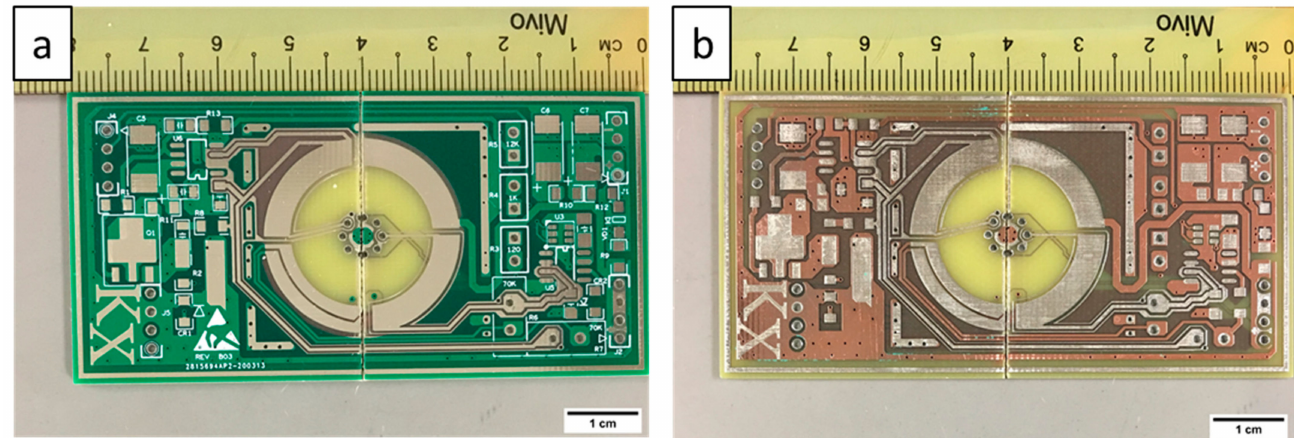
Figure 7. Coarse PCB pieces ( a ) before the removal of solder mask, and ( b ) after the removal of solder mask (conditions: 3M NaOH, 70 ◦ C, 2 h, 1 cm × 1 cm PCB pieces, S/L ratio